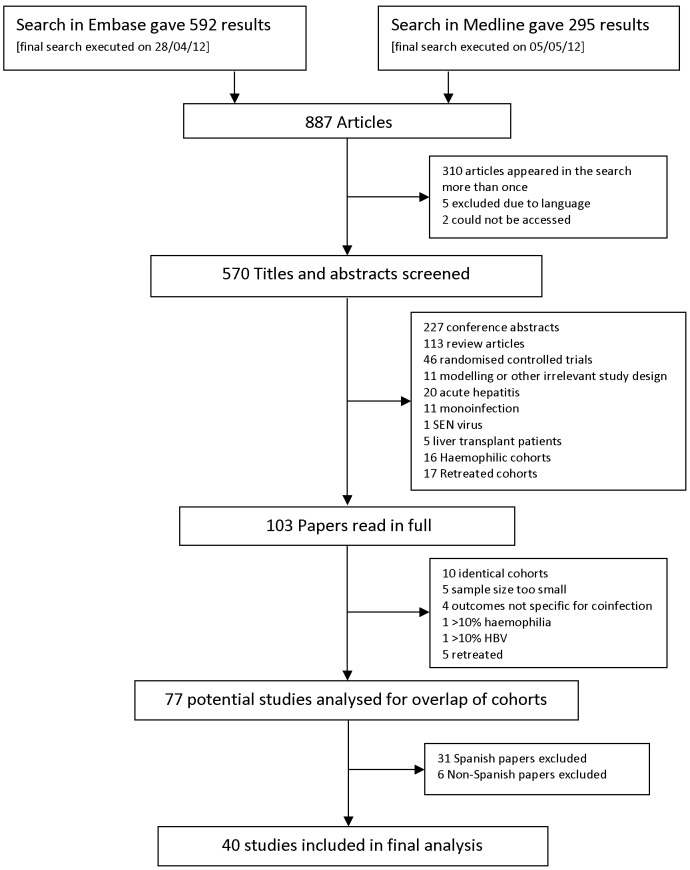
Identification of studies for inclusion.